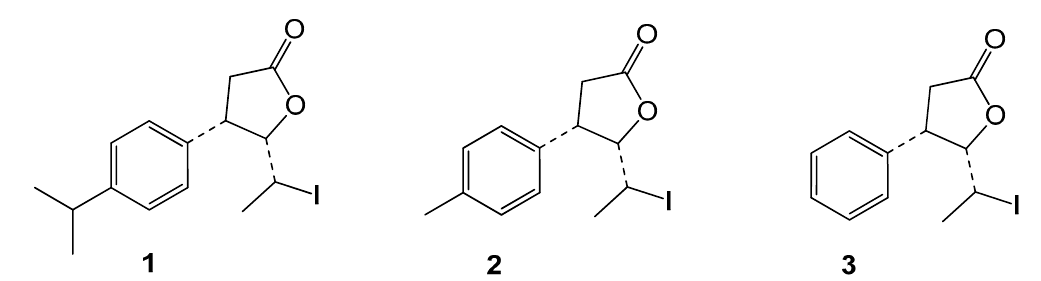
β -aryl- δ -iodo- γ -lactones 1 – 3